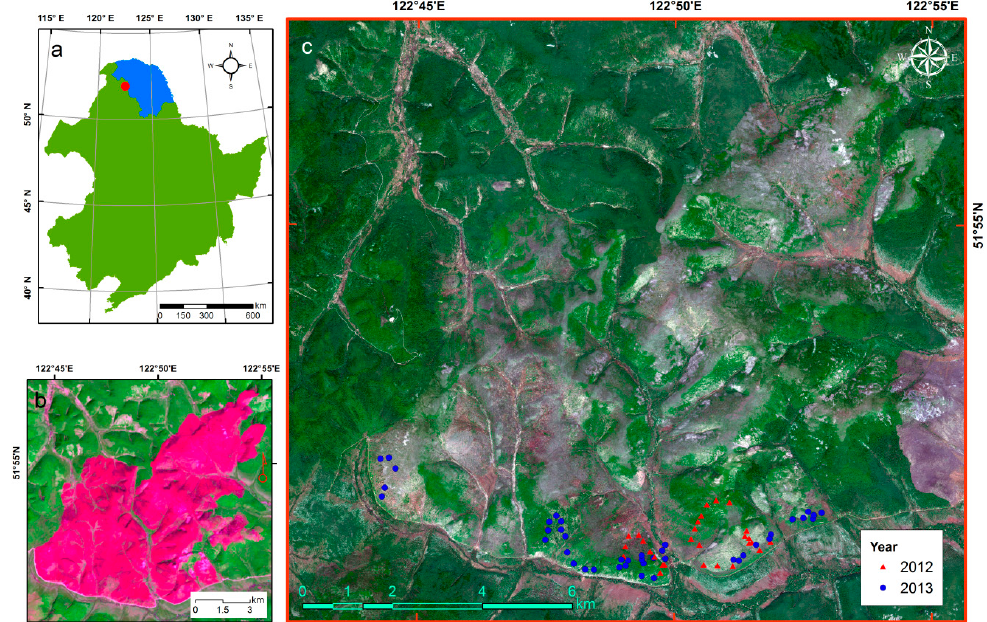
Figure 1. Spatial location of the study area ( a , red dot) in Great Xing’an Mountains ( a , in blue) of northeastern China ( a , in green). The false color Landsat image ( b , R: TM7, G: TM4, B: TM3) acquired on 24 May 2002 exhibits an overview of two-year post-fire landscape, while the WorldView-2 image ( c ) shows the post-fire landscape after 14 years recovery. The red and blue dots are field plots explored in 2012 and 2013, respectively.